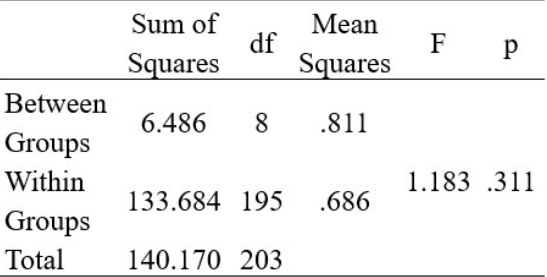
Table 9 . Impact of prospective teachers’